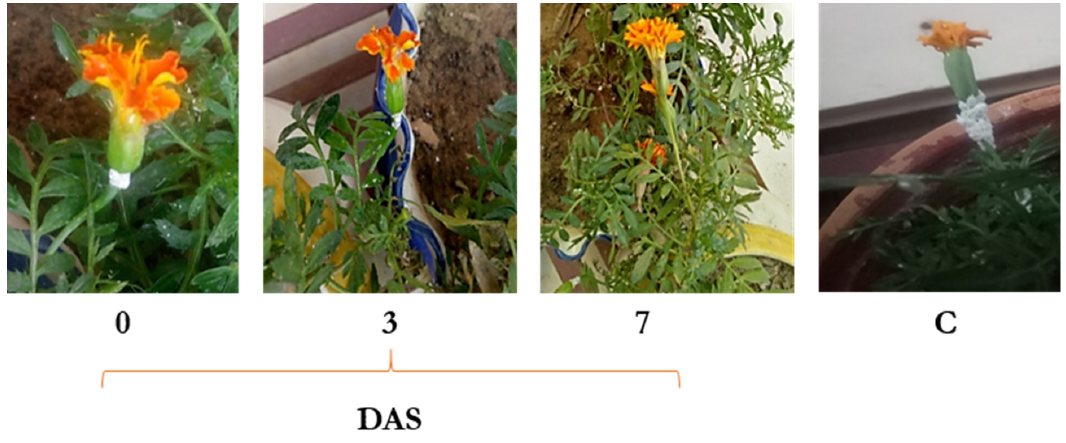
Figure 3. In vivo insecticidal activity of by-product waste from Eucalyptus globulus essential oil distillation DAS: days after spray, C: untreated plant